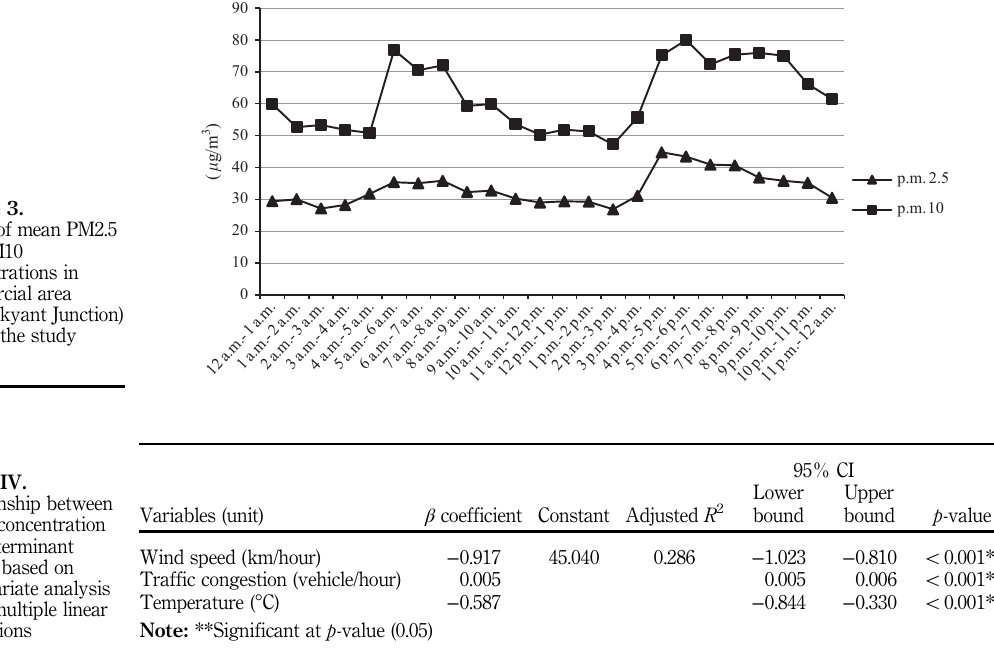
Variables (unit) β coefficient Constant Adjusted R 2